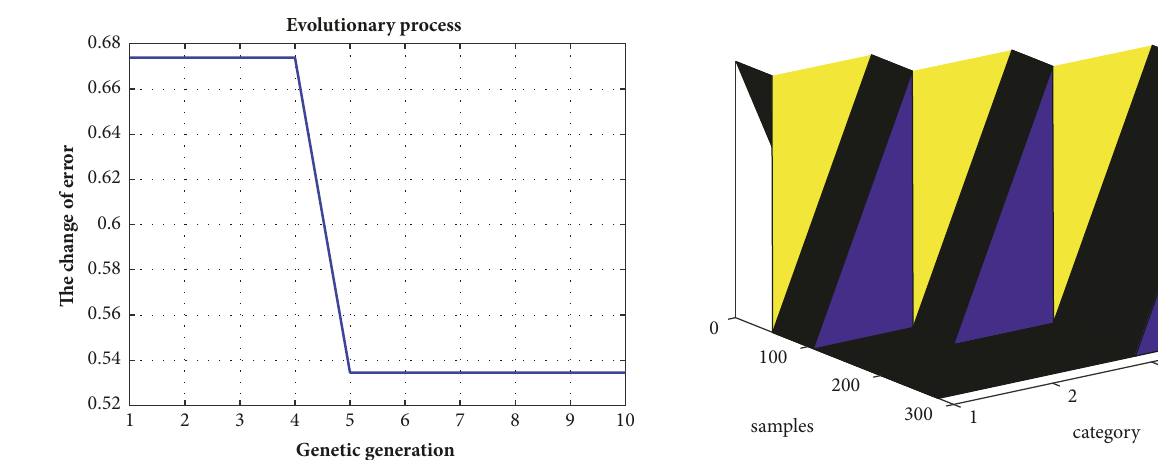
Figure 7: Evolutionary process.